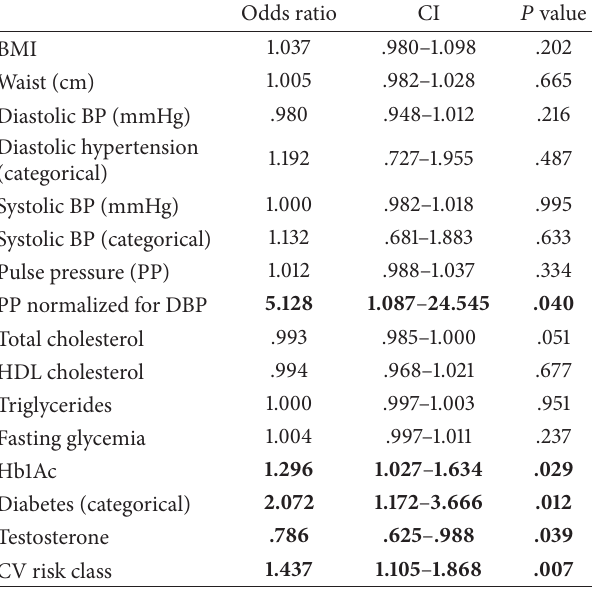
Table 3: Odds ratio for severe ED. Variables are individually tested in a model adjusted for age, smoking, and centre. Significant ORs are highlighted in